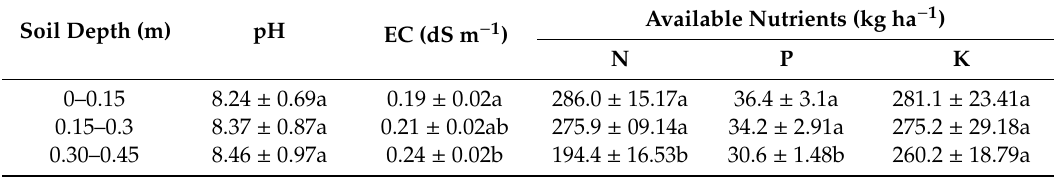
Table 2. Initial soil